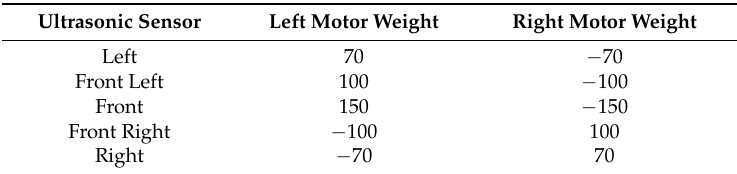
Table 1. The ultrasonic sensor weights used in the experiments.